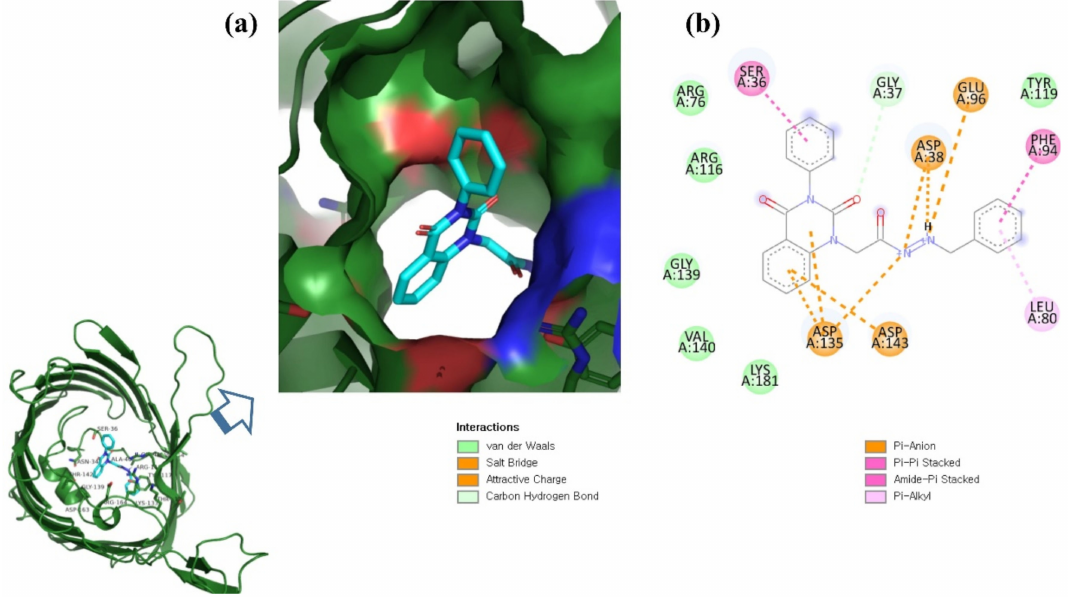
Figure 5. Visualization of control compound in the binding pocket of OmpU ( a ); 2D view of residues of OmpU interacting with the control compound ( b